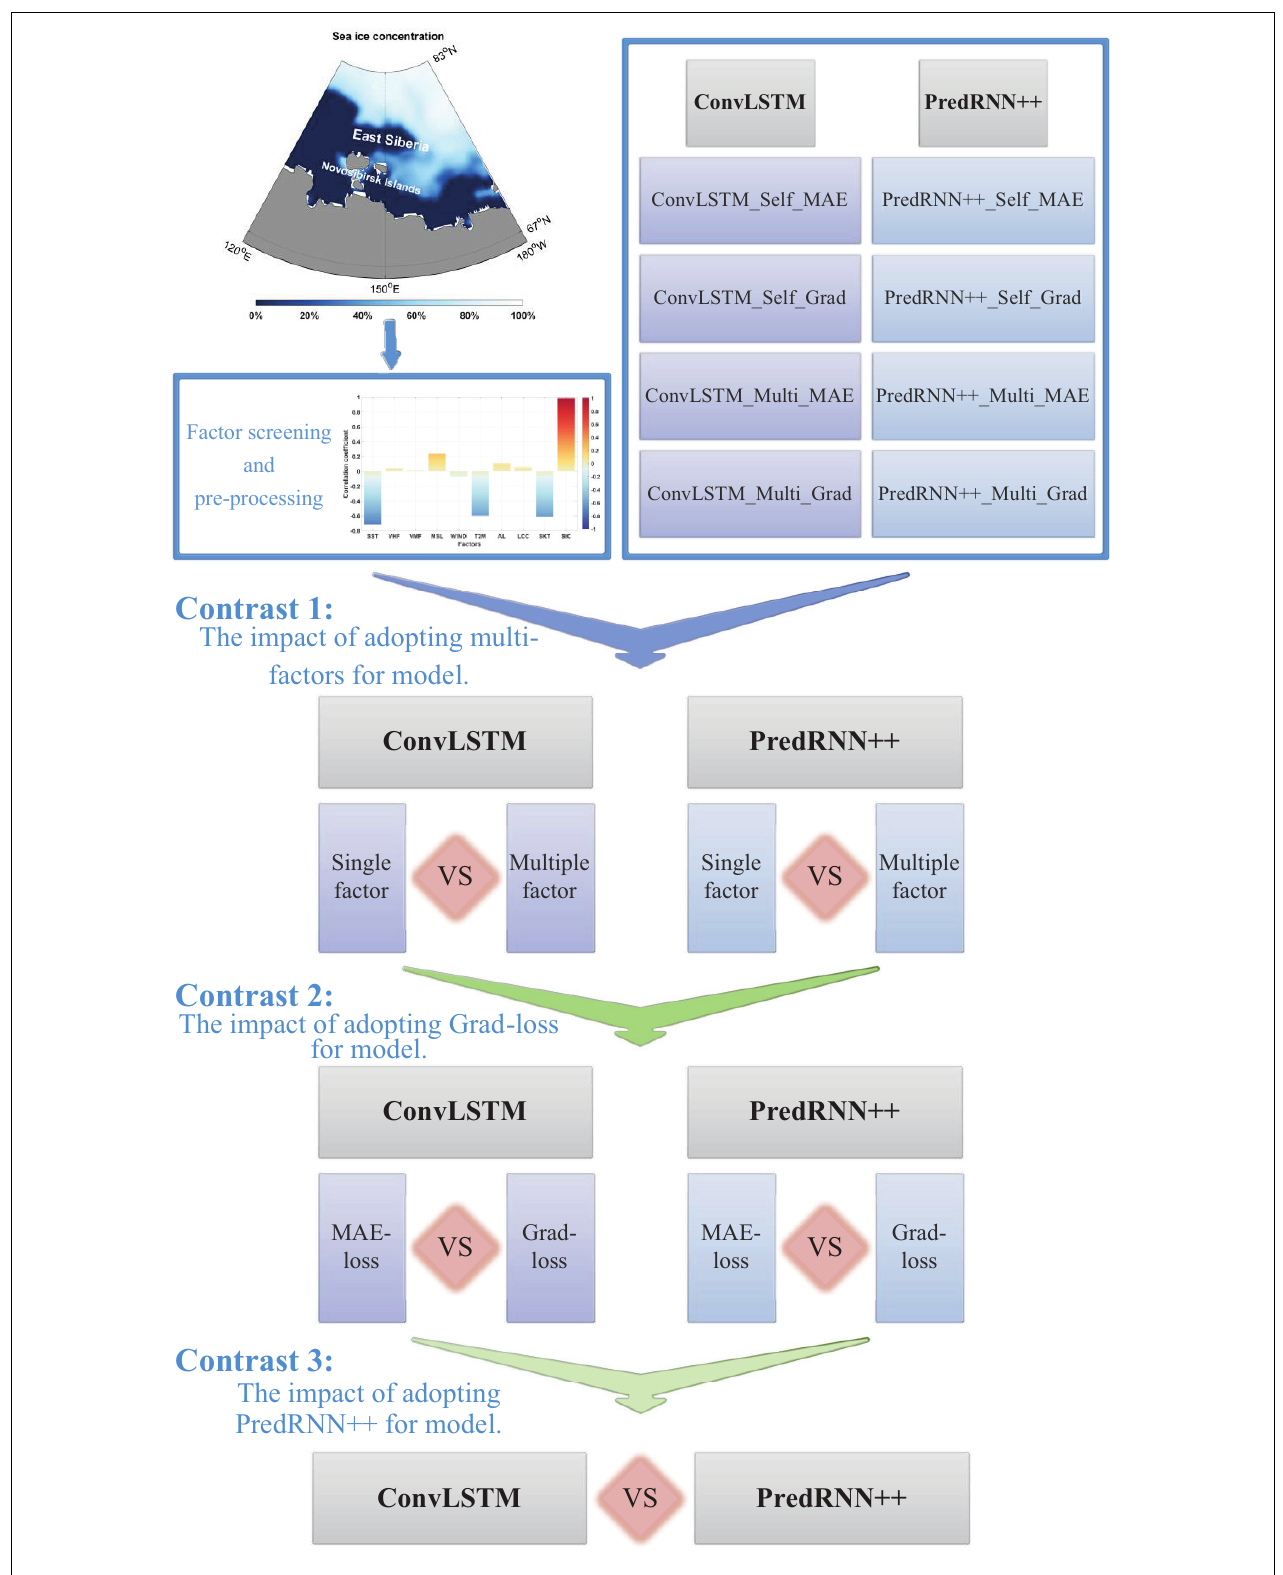
FIGURE 3 | Model design and workflow schematic. Based on SSIM, MAE, and DIFF, the prediction effects of each model are compared in order.